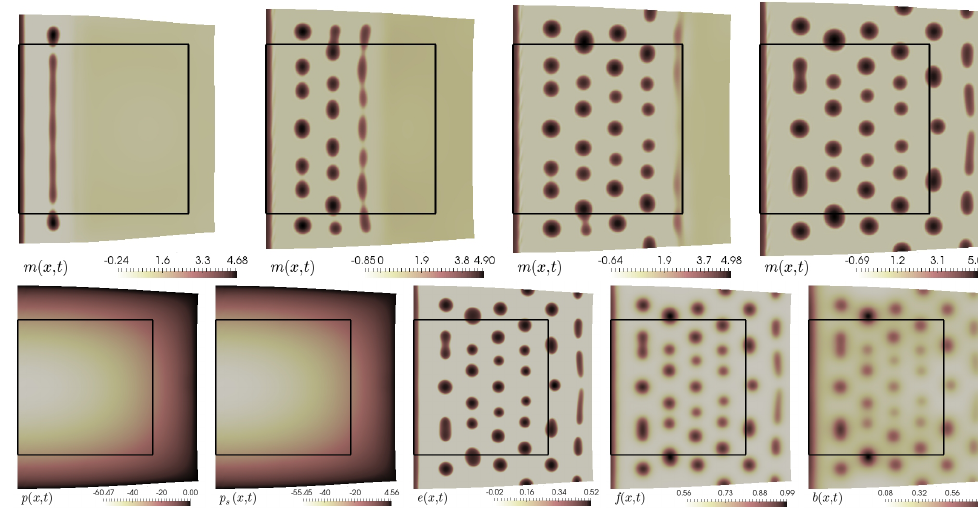
Figure 8. Evolution of the mesenchymal cell concentration under finite growth using the formula- tion (30), snapshots are taken at t = 160,280,400,520 (top). Second row: plots at t = 520 of fluid pressure, solid pressure, epithelium, FGF, and BMP. Simulations using ξ f = −